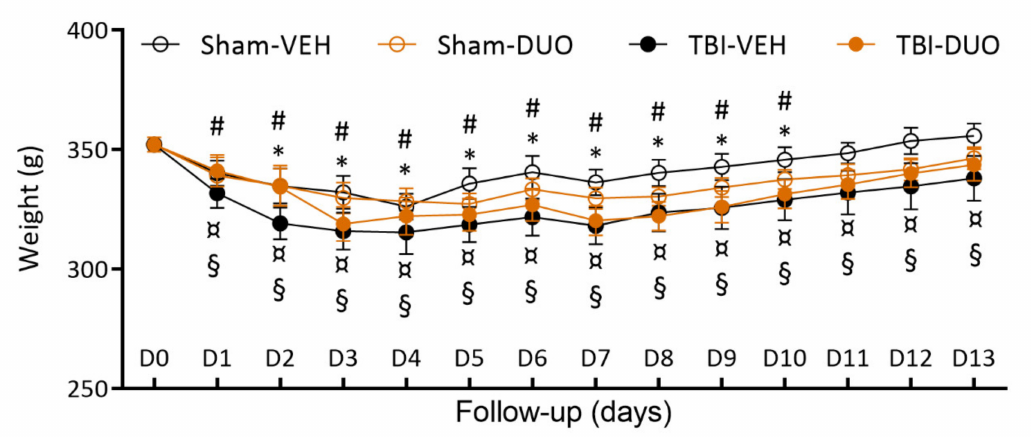
Figure 4. Body weight. Mean body weight of each treatment group at different time-points after sham-operation or traumatic brain injury (TBI) over the 2-week follow-up. The weight of Sham-VEH or Sham-DUO treated animals returned to the pre-operation (day [D] 0) weight by D11. TBI-VEH or TBI-DUO treated animals, although they gained weight, did not reach their D0 weight during the follow-up. Overall, body weight did not differ between treatment groups at any time-point ( p > 0.05, Mann–Whitney U -test). Abbreviations: D, day; DUO, duotherapy treated with N-acetylcysteine and sulforaphane; g, gram; TBI, traumatic brain injury; VEH, vehicle; wk, week. Statistical significances: * p < 0.05, compared to D0 within Sham-VEH group; # p < 0.05, compared to D0 within Sham-DUO group; ¤ p < 0.05, compared to D0 within TBI-VEH group; § p < 0.05, compared to D0 within TBI-DUO group (Wilcoxon). Data are presented as mean ±